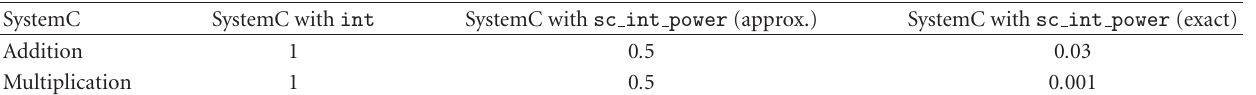
Figure 13: Interface conversion for generating a heterogeneous accuracy simulation model. Table 3: Simulation speed comparison.